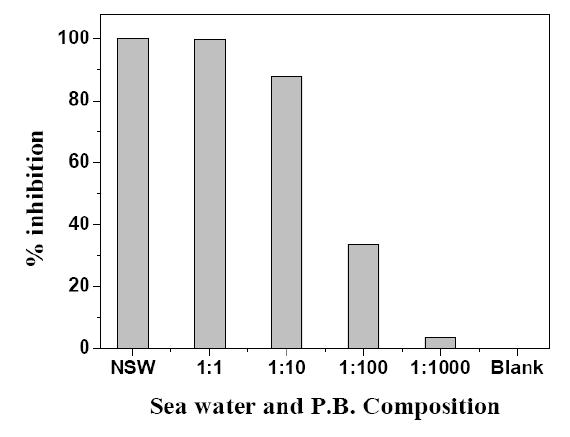
Figure 7 . Matrix effect of sea water on enzyme activity. Filtered sample was diluted with 0.1 M PB pH 7.5 in various dilution range and shows minimum matrix effect around 1:1000 dilution where 1 part comprise of sea water and 1,000 part PB (NSW; natural sea water).